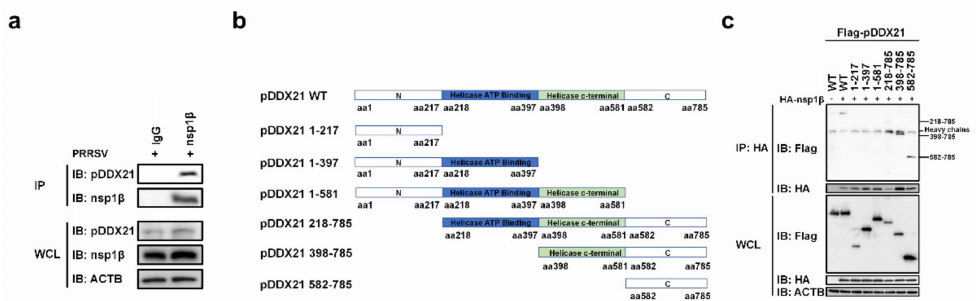
Figure 6. nsp1 β interacts with the C-terminal of pDDX21 ( a ) iPAM cells were infected with PRRSV (MOI = 0.5). At 36 hpi, these cells were lysed and immunoprecipitated with anti-nsp1 β or anti- IgG monoclonal antibodies. WCL and IP complexes were analyzed by immunoblotting with anti- DDX21, anti-nsp1 β , and anti- β -actin antibodies; ( b ) Schematic representation of WT pDDX21 and its truncation mutants. ( c ) HEK-293T cells were co-transfected with expression plasmids of Flag- tagged pDDX21-WT (3 µ g) or its truncation mutants (3 µ g) and HA-tagged nsp1 β (3 µ g). At 30 h post-transfection, these cells were lysed and immunoprecipitated with an anti-HA monoclonal antibody. WCL and IP complexes were analyzed by immunoblotting with anti-Flag, anti-HA, or anti- β -actin